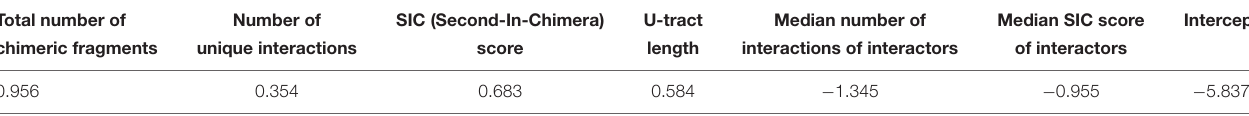
TABLE 3 | Weights of the logistic regression model for stationary phase data a .